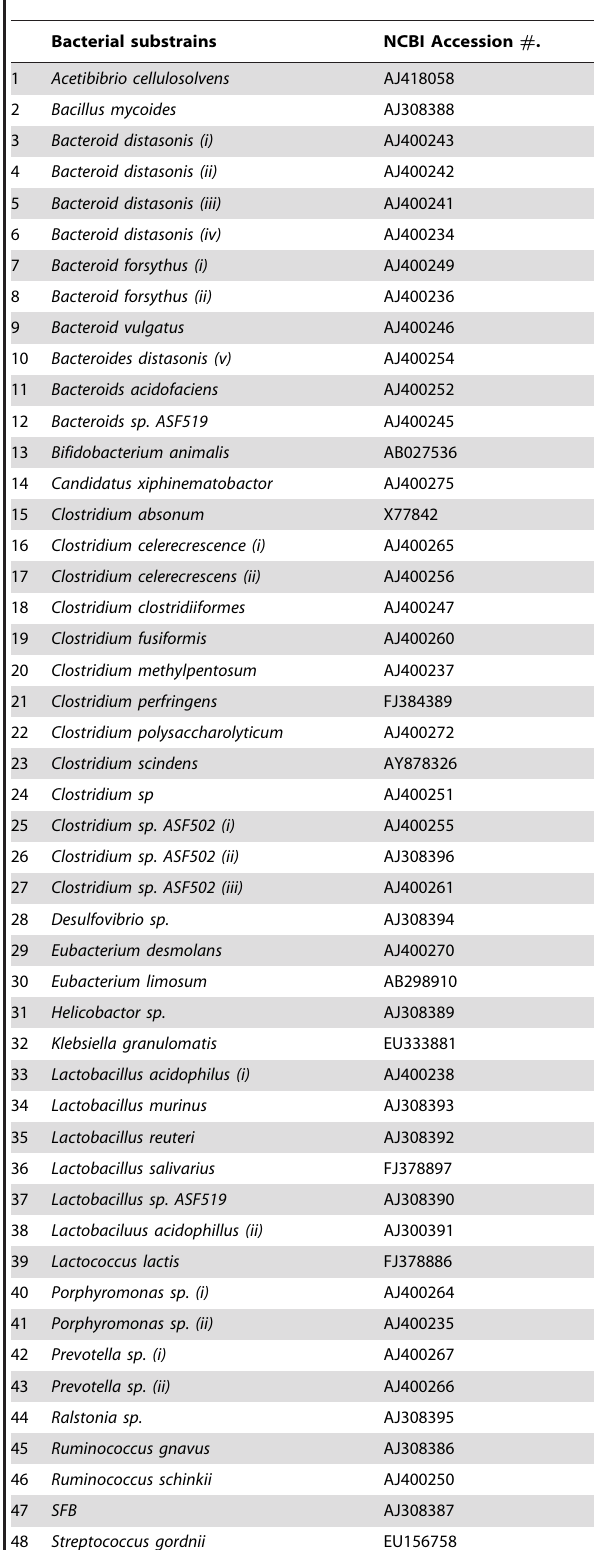
Table 1. Gene accession numbers of the 16 s rRNA gene assessed in this